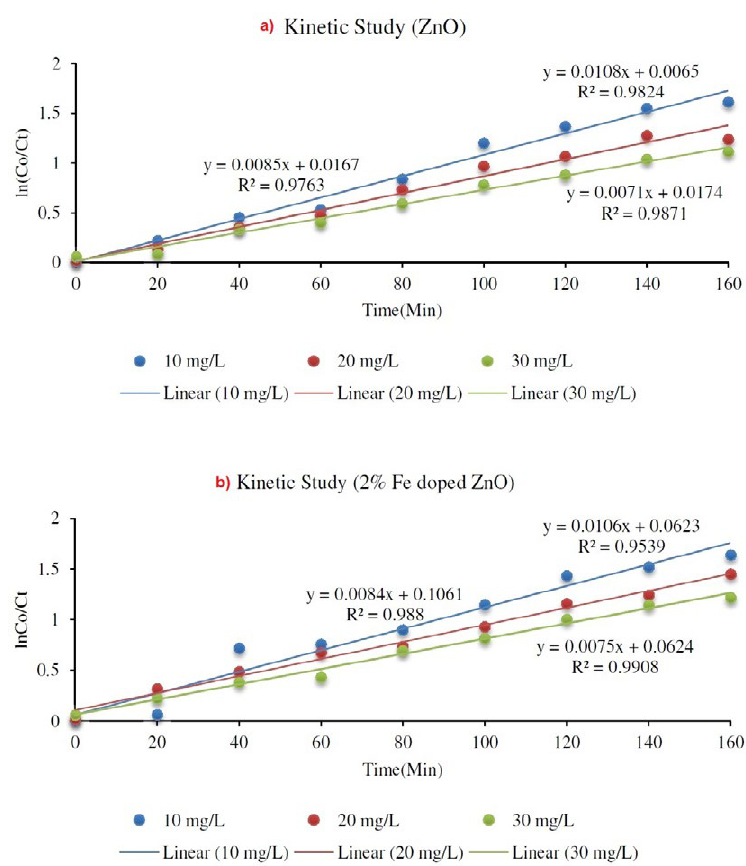
Fig. 10. Pseudo-first-order kinetics for photocatalytic degradation of (a) MB, conditions pH=2, dye concentration. 10, 20, 30 mg/L and catalyst dose 1 g/L irradiation time 140 min. (b) MB, conditions: pH= 2 dye concentration. 10, 20, 30 mg/L and catalyst dose 1 g/L irradiation time 140 min.